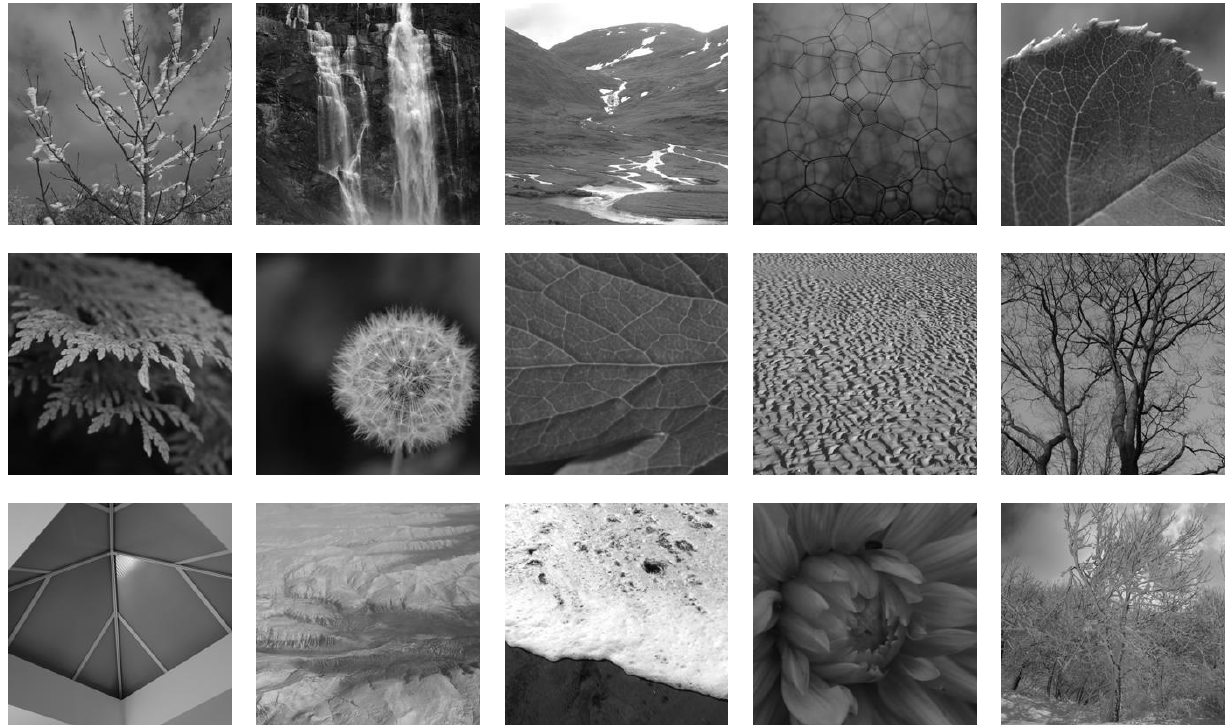
Figure 3. The examples of fractal images in the BOSSBase dataset.